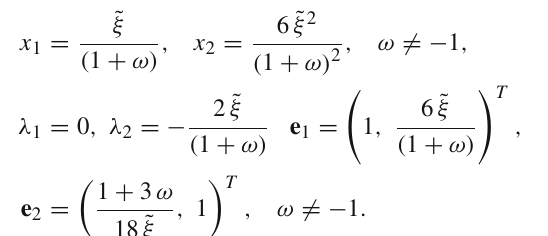
The case with two fixed points, along the flat curve solu- tion, is more involved than the case of a single point along the x 2 axis. In the parameter space where (cid:13) 2 < 0 there are no fixed points at all. When (cid:13) 2 = 0 an emergent single fixed point (non-hyperbolic one) appears whose coordinates, asso- ciated eigenvectors and eigenvalues are, after using Eqs.